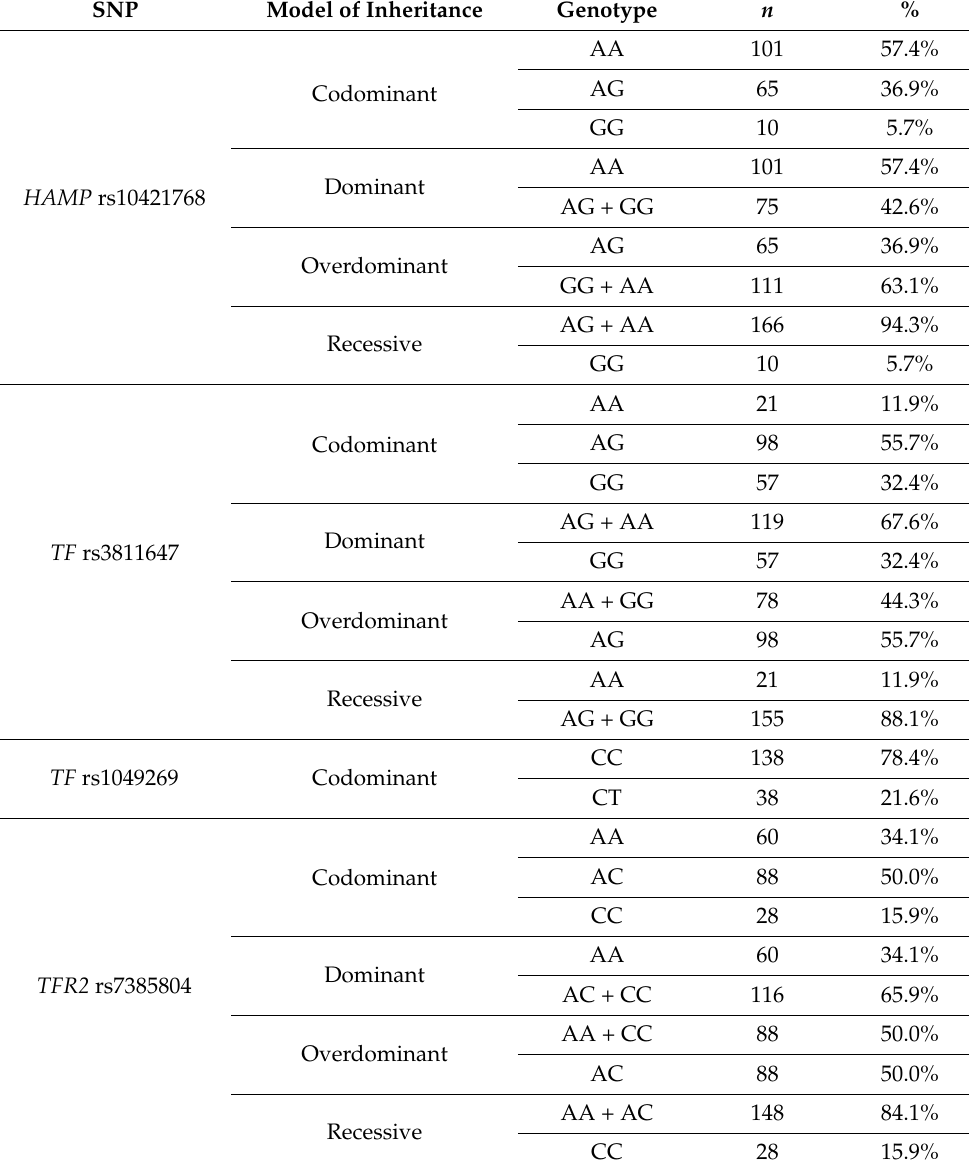
Table 3. Distribution of genotypes in the studied inheritance models among the study group. SNP Model of Inheritance